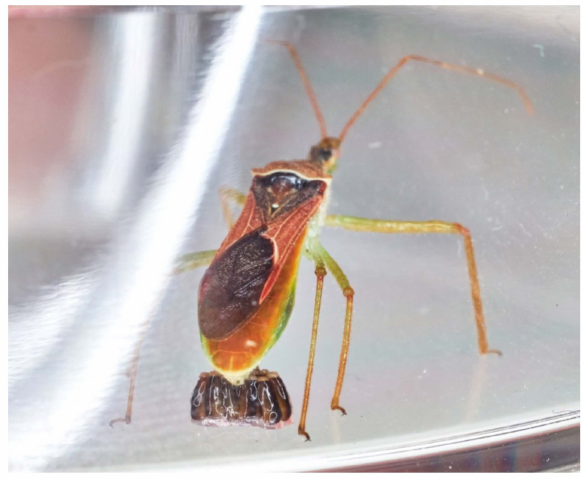
Figure 5. LAB female during egg